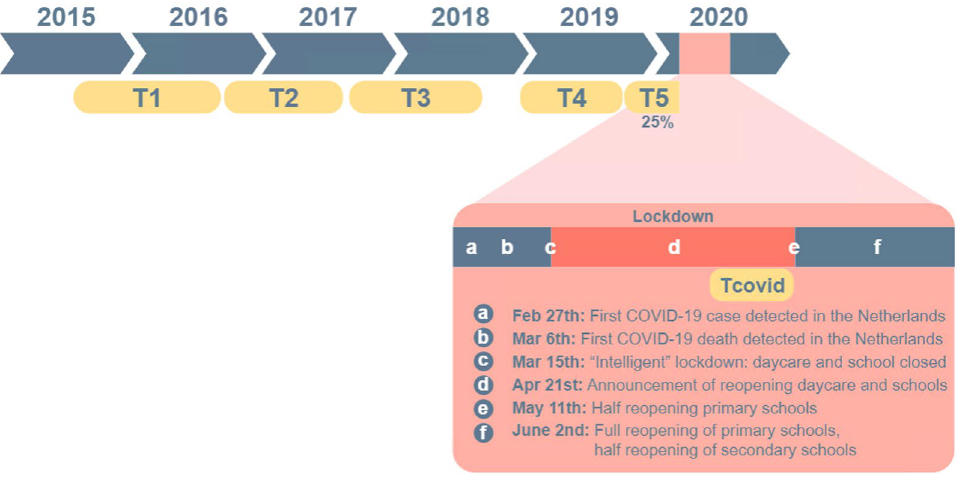
Figure 5. Timeline of data collection and COVID-19 related events in the Netherlands. The data collection of T5 had to be paused due to COVID-19 lockdown. As only 28% of the sample had data on T5 (collected before the COVID-19 lockdown), we did not include these data in the current study. This timeline was created by O.B. using Adobe Illustrator CC 2018, https ://www.adobe .com/nl/produ cts/illus trato